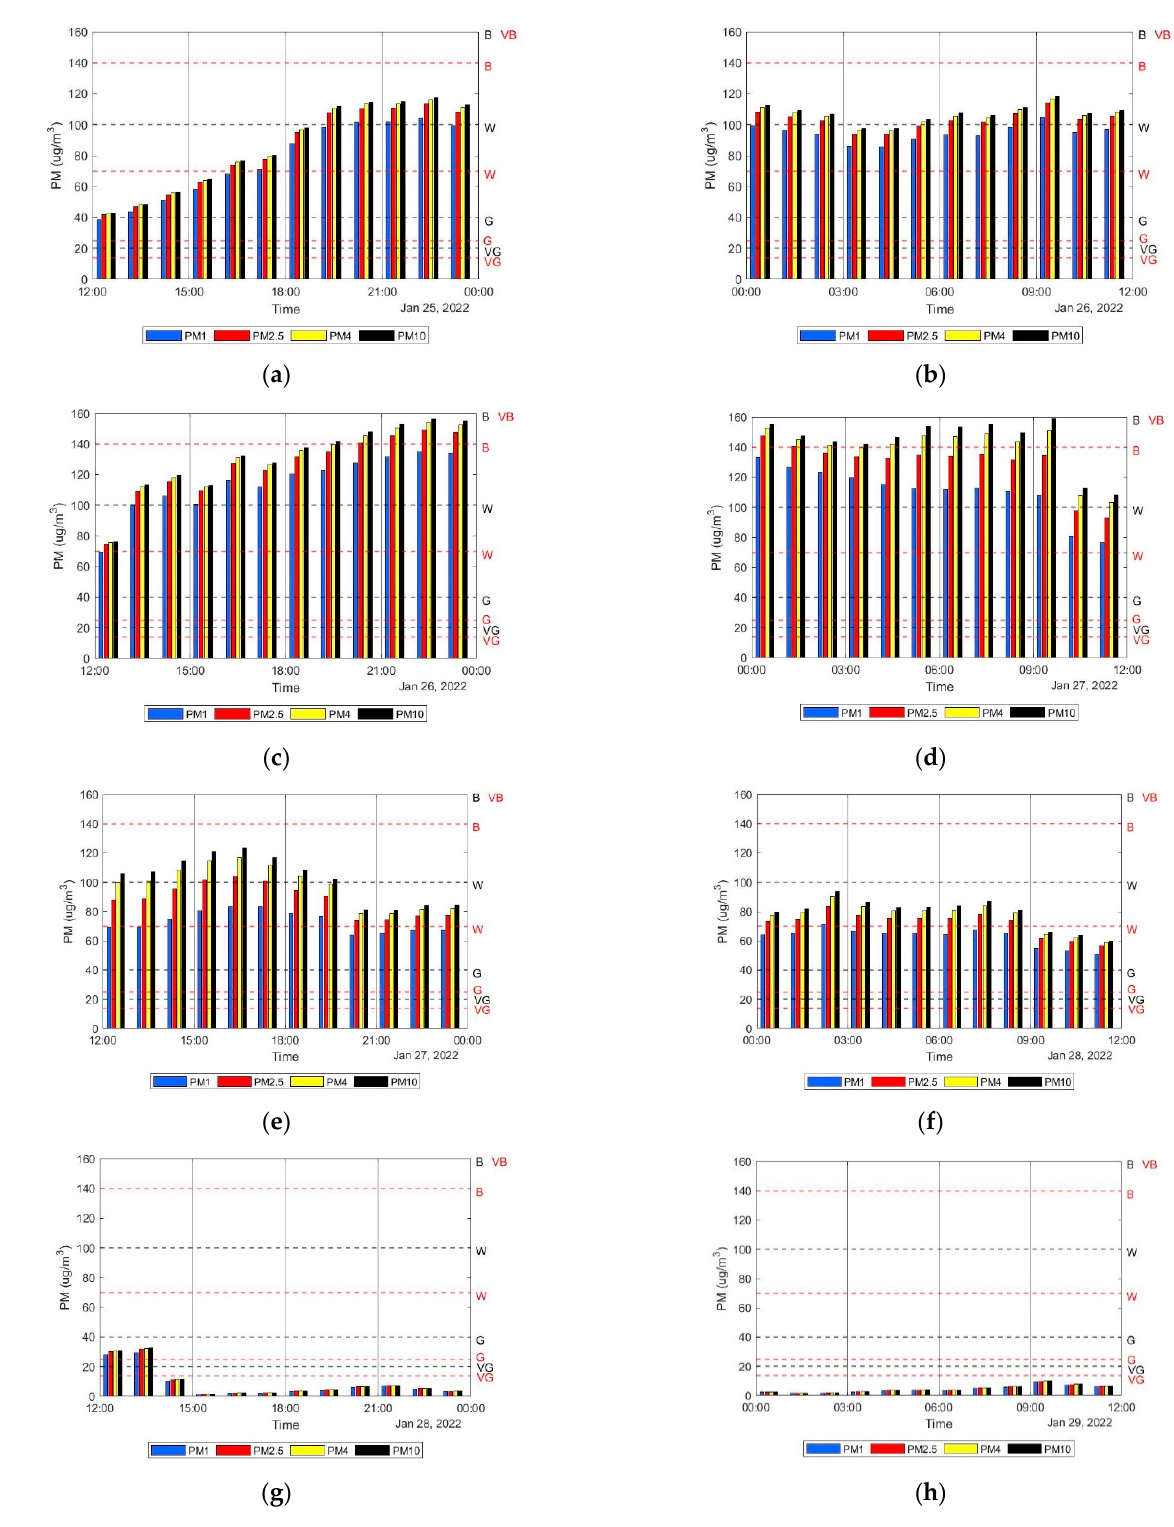
Figure 3. Hourly averages of mass concentration of PM1, PM2.5, PM4, PM10 measured in January 2022 in Košice at DTIEE: ( a ) 25th 12:00–24:00; ( b ) 26th 0:00–12:00; ( c ) 26th 12:00–24:00; ( d ) 27th 0:00–12:00; ( e ) 27th 12:00–24:00; ( f ) 28th 0:00–12:00; ( g ) 28th 12:00–24:00; ( h ) 29th 0:00–12:00. Dashed lines represent limit values for the air quality with respect to concentration of PM2.5 (red) or PM10 (black). Abbreviations next to the dashed lines indicate the air quality: VG = Very Good, G = Good, W = Worsened, B = Bad, corresponding to Table 4.